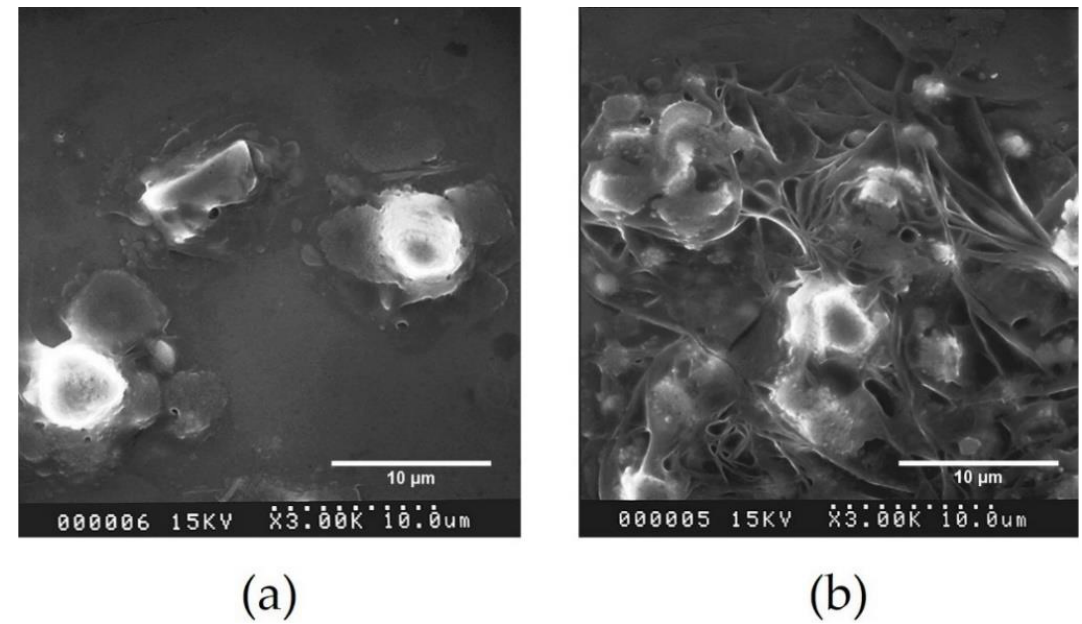
Figure 8. Scanning electron micrographs of DPNR particles ( a ) before and ( b ) after the photochemical process with 20% H 2 O 2 and TiO 2 film irradiated under UV light for 5 h on the quartz substrate.